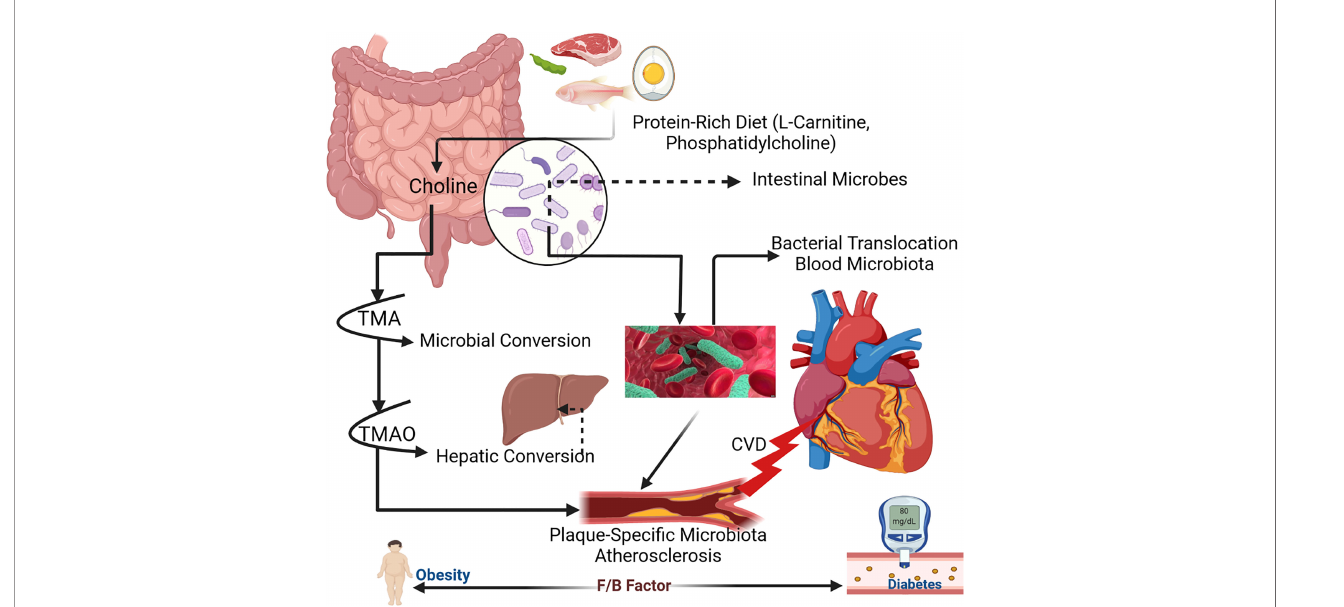
FIGURE 1 | Mechanism of human gut microbiota within host body (Zhu et al.,